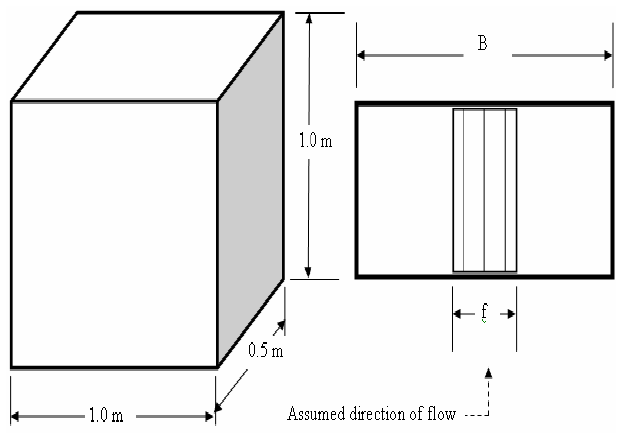
Figure2: Tanks used in the experiments (one tank is shown) water obtained from the distribution system. The